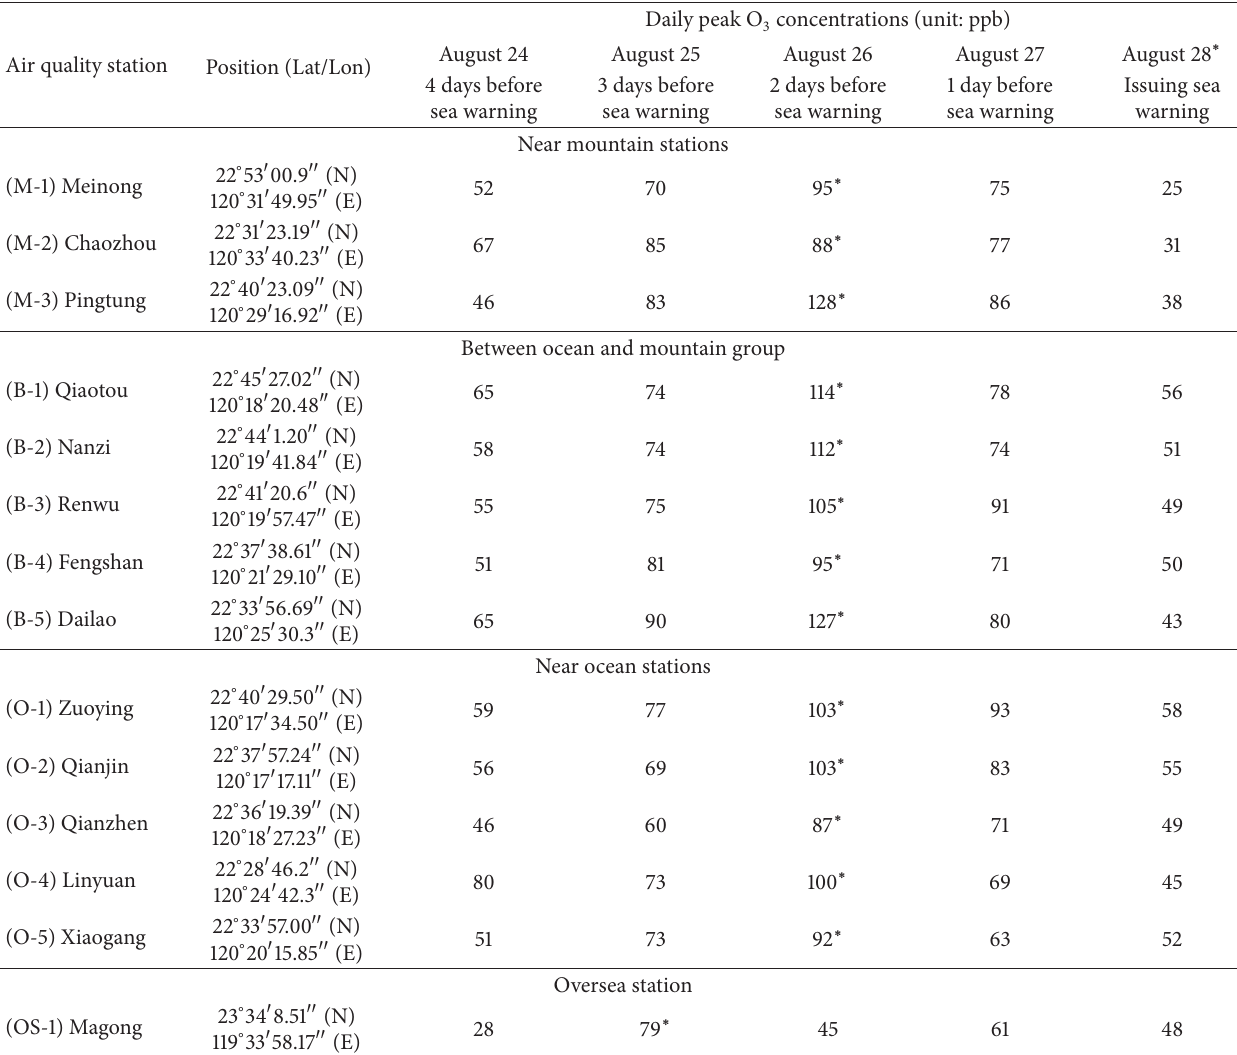
Table 3: Ozone daily peak concentration observed using air quality monitoring stations located in Southern Taiwan before and after the invasion of typhoon Nanmadol (August 24–28,